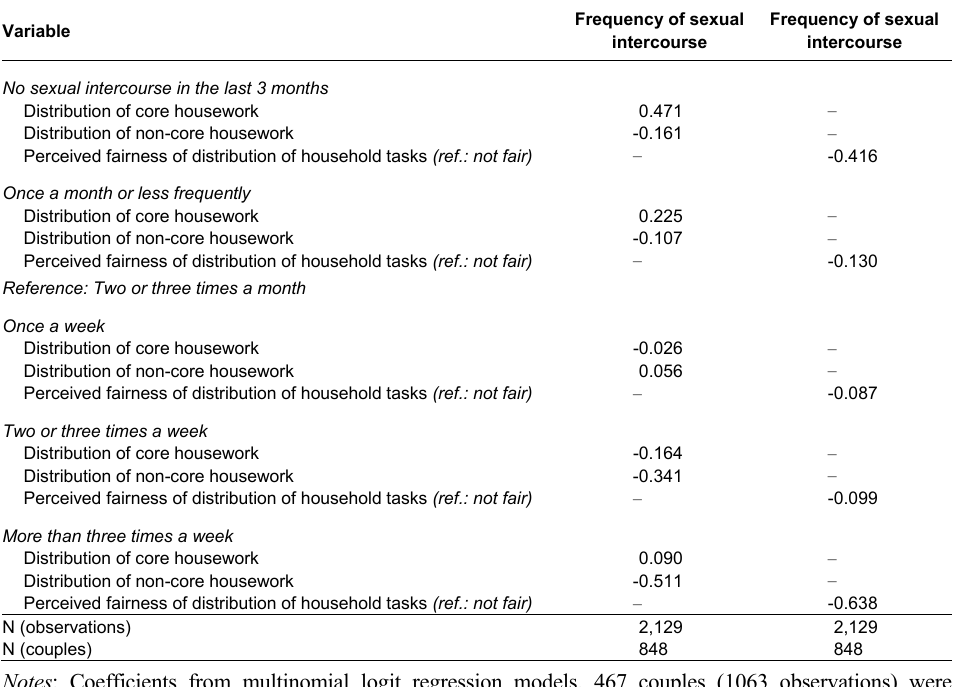
Table A.5 : Summary of multinomial logit fixed effects regression analyses estimating the frequency of sexual intercourse